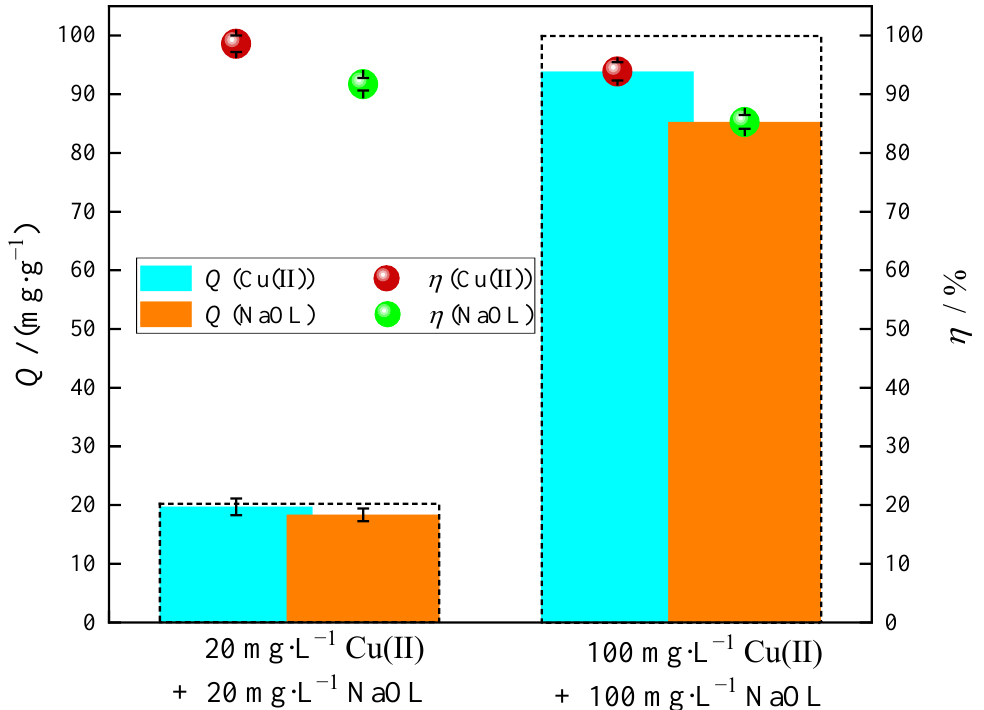
Figure 9. Adsorption–desorption cycles of Cu(II) and NaOL on SiO 2 –g–PBMA–b–PDMAEMA.